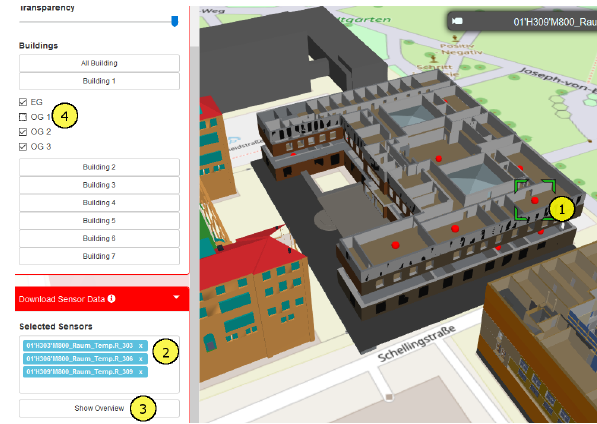
Figure 7. Web interface and data download procedure in the 3D platform. 1) Selecting a sensor to download can be done by clicking the sensor. 2) A list of selected sensors. 3) A button to show sensor data overview before downloading the data. The data overview is the same as the one in the 2D platform. 4) Each floor of the building, including the sensors within, can be shown or hidden independently. Base Map c (cid:13) OpenStreetMap